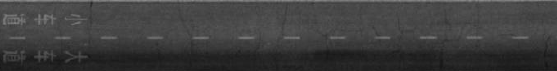
Figure 1. Georeferenced intensity image of pavement surface.